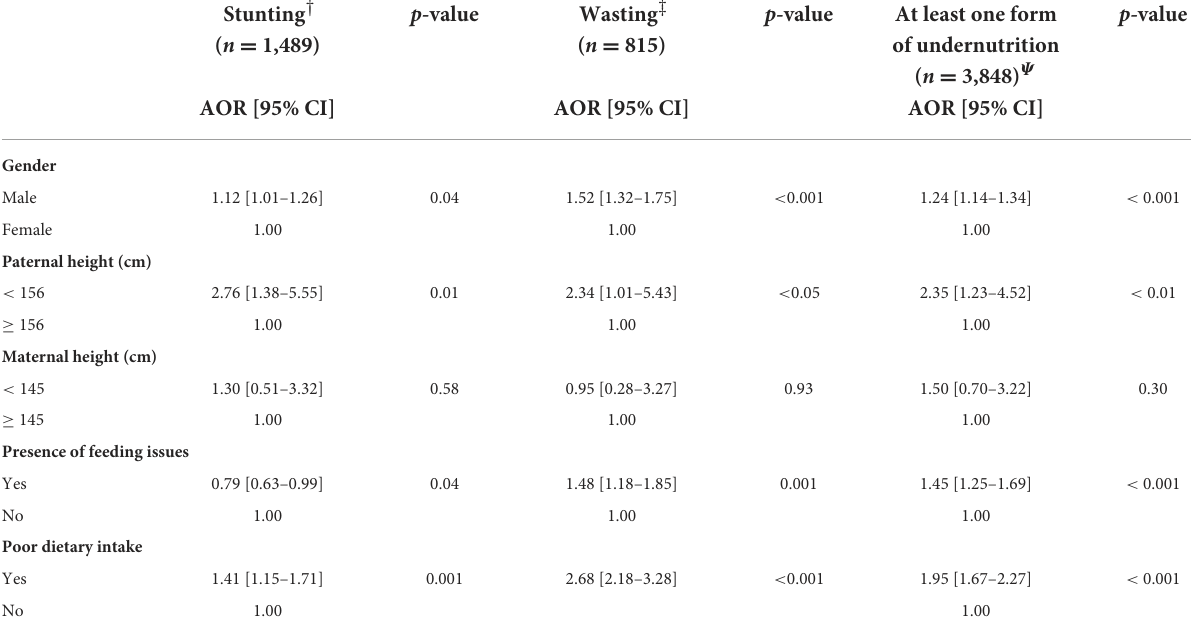
TABLE 5 Factors affecting nutritional status of 10,454 Malaysian children aged 1–5